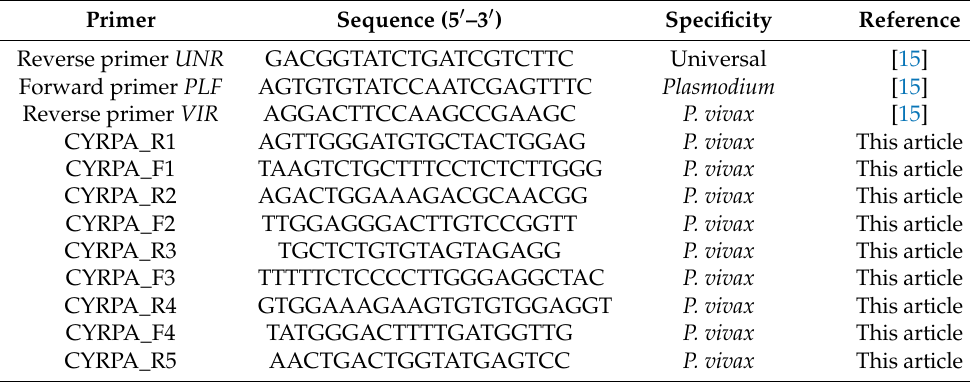
Table 1. PCR primers used for the diagnosis and amplification of the pvcyrpa gene. Primer Sequence (5 (cid:48) –3 (cid:48) )